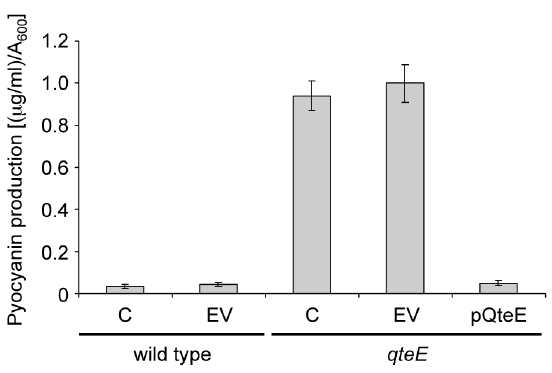
Figure 3. Effect of QS dysregulation caused by qteE mutation on pyocyanin production in P.aeruginosa . Levels of pyocyanin measured in cell-free supernatants from cultures of the indicated strains grown till A 600 < 3.5. C, no plasmid; EV, pBBR1MCS-5 empty vector;